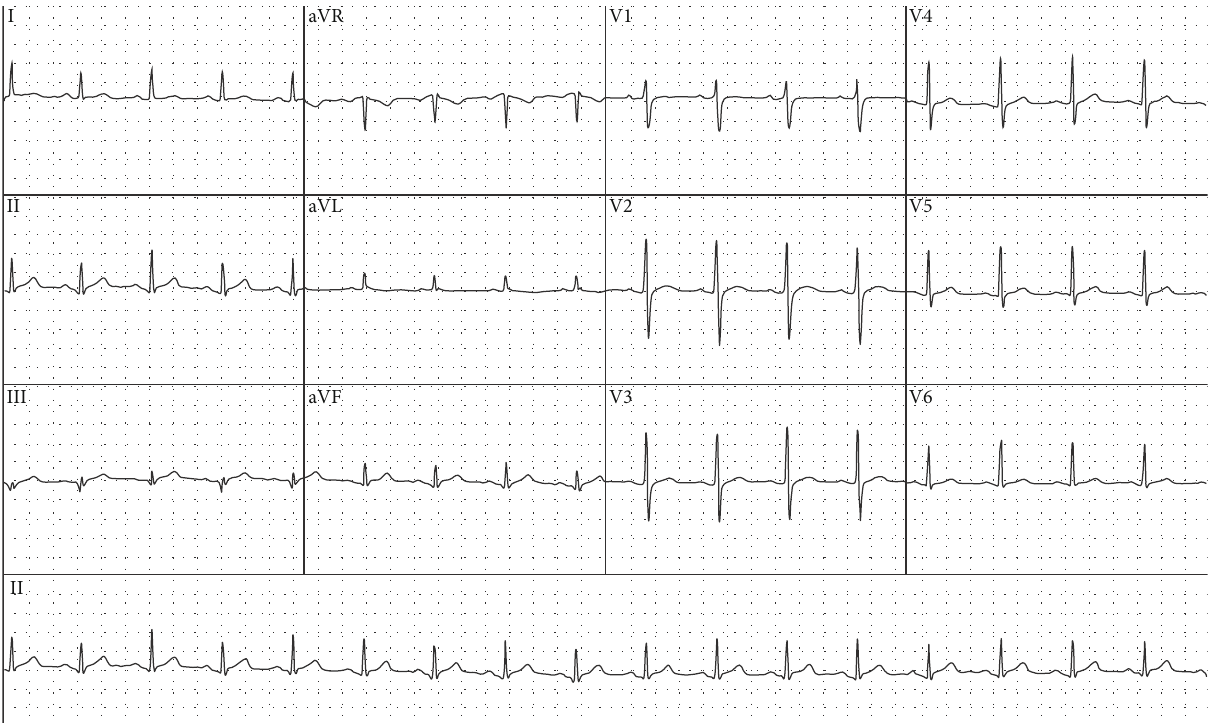
Figure 4: Electrocardiogram of the patient. Electrocardiogram (ECG) recorded during outpatient follow-up in cardiology clinic. This ECG shows resolution of widespread ST-segment elevation following the initial admission with